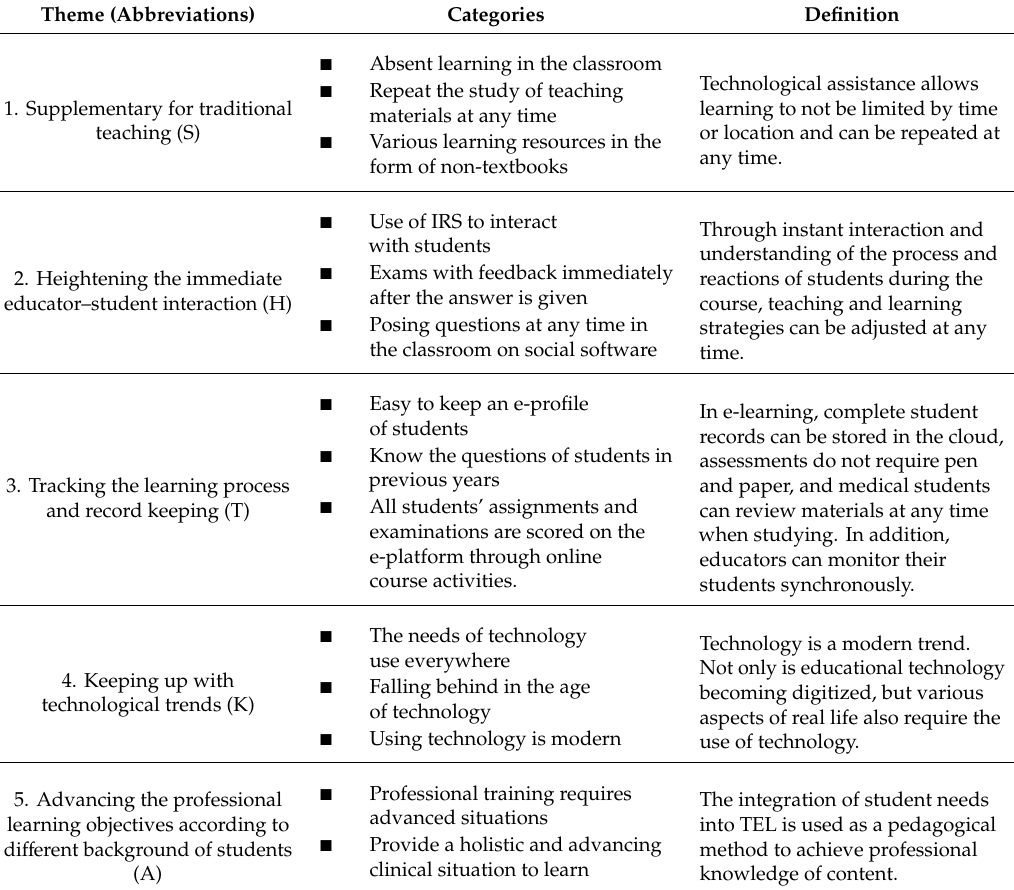
Table 2. Qualitative analysis of health profession educators (N =